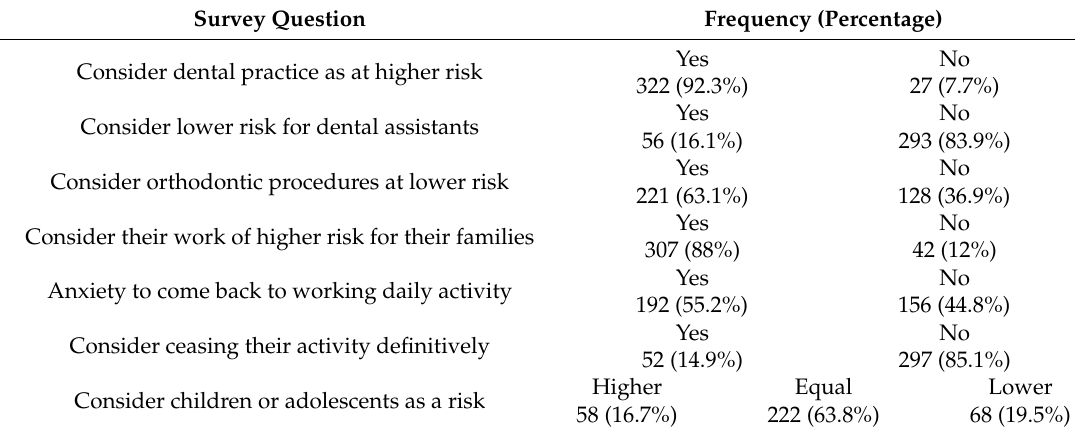
Table 2. Frequencies and percentages of replies to perceived risk, anxiety, and distress